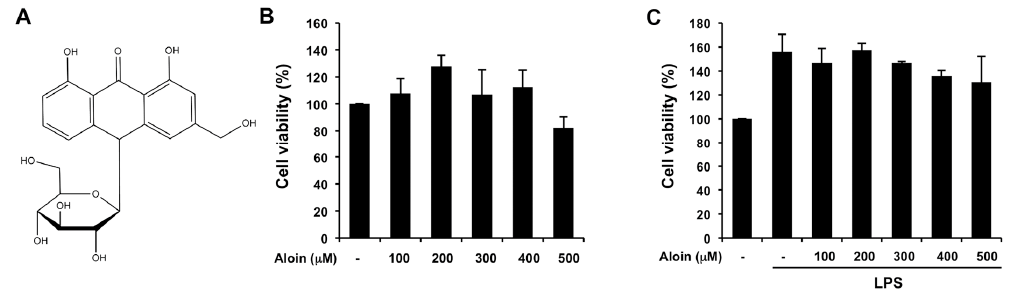
Figure 1. Aloin does not affect cell growth in murine macrophages: ( A ) Chemical structure of aloin; ( B ) RAW 264.7 cells were treated with various concentrations of aloin (100 µ M, 200 µ M, 300 µ M, 400 µ M, and 500 µ M) for 24 h. The total number of viable cells was determined by methyl thiazolyl tetrazolium (MTT) assay. Values are mean ± SD of three independent experiments; ( C ) RAW 264.7 cells were treated with various concentrations of aloin and lipopolysaccharide (LPS) (100 ng/mL) for 24 h. The total number of viable cells was calculated. Values ARE mean ± SD of three independent experiments.